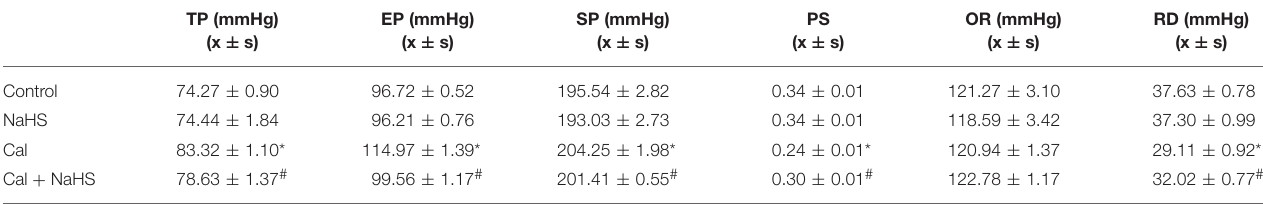
TP,thresholdpressure;EP,equilibriumpressure;SP,saturationpressure;OR,operatingrange;PS,peakslope;RD,reflexdecrease.Valuesaremean ± SD(n = 6). * P < 0.05,Calcification group vs. Control group; # P < 0.05, Cal group.